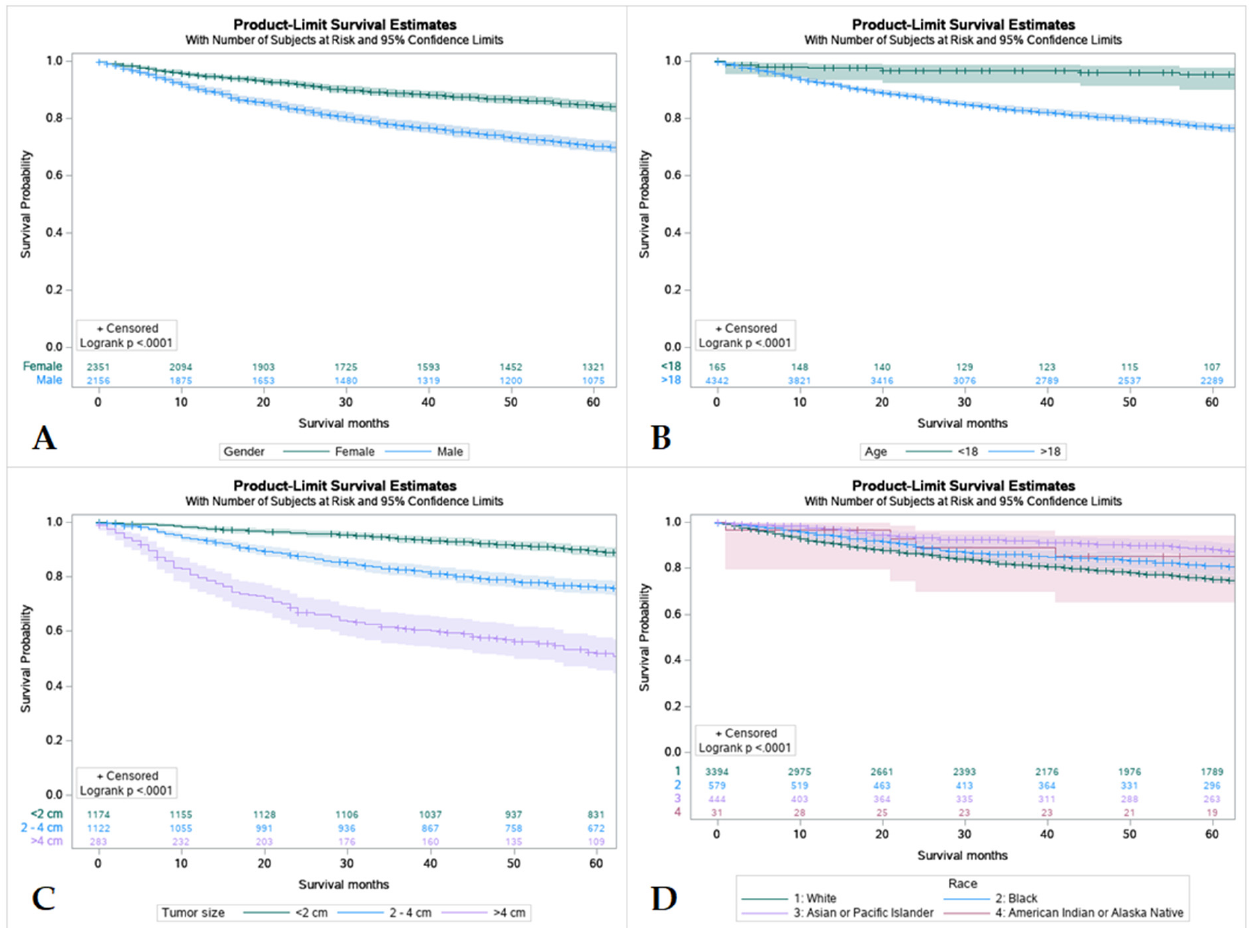
Figure 3. Kaplan Meier graphs displaying comparative survival analysis of patients with mucoepi- dermoid carcinoma (MEC) over the span of 60 months (5 years) by ( A ) Gender, ( B ) Age, ( C ) Tumor size, and ( D ) Race. Females had a high 5-year survival compared to males. Patients < 18 years old had higher 5-year survival compared to adult (>18 years old). Whites had the worst 5-year survival compared to Blacks, Asian or Pacific Islanders, and American Indian or Alaska Native. Patients with tumors less than 2 cm in size had the highest 5-year survival and patients with tumors less than 4 cm had the lowest.